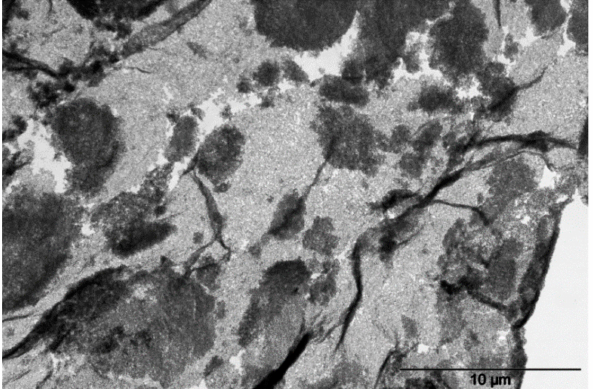
Figure 3. TEM picture of the PTFE / SiO 2 (c)F nanocomposite at a 10 µ m